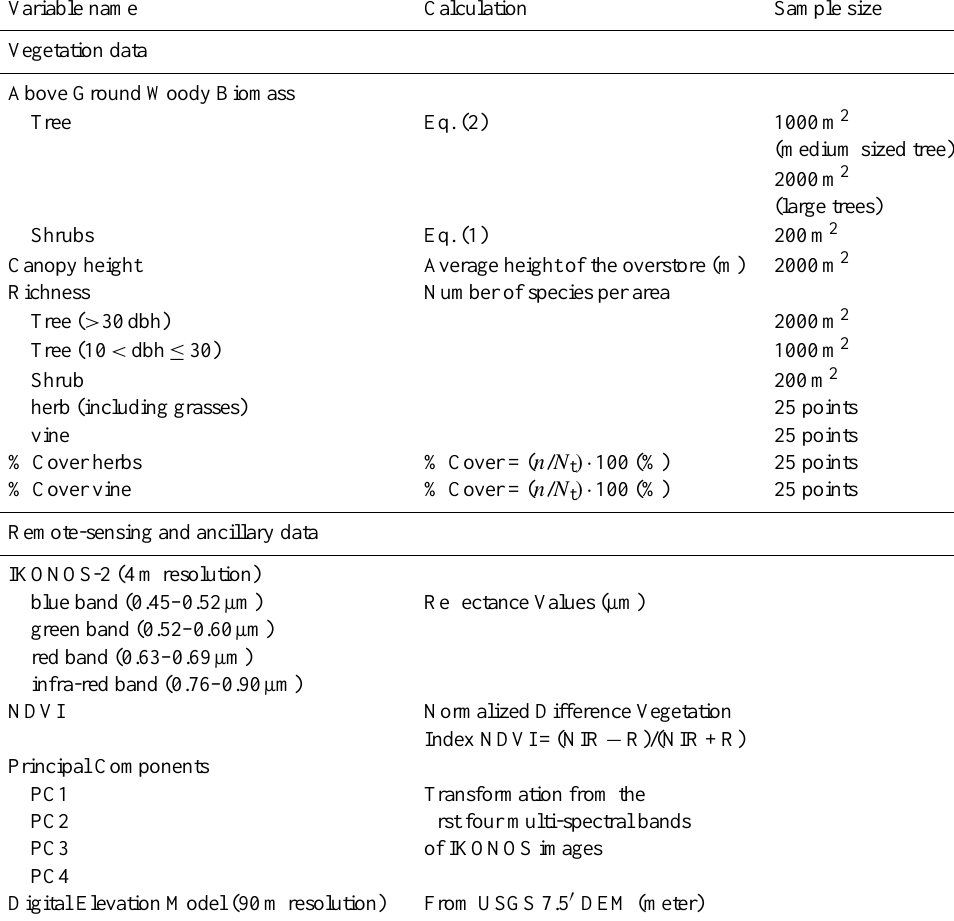
Table 1. Vegetation data obtained from field sampling and the available remote-sensing and ancillary imagery. Sample size varies with the life form of plant. Biomass of trees and shrubs are calculated using the allometric equation developed by Chave et al. (2005) and by Barbosa and Ferreira (2004), respectively. ρ is woody density, d is diameter at breast height, H is species height, Cb is circumference at ground height (cm), n is the number of points touched by a species, and N t is the total number of points in a sample (25